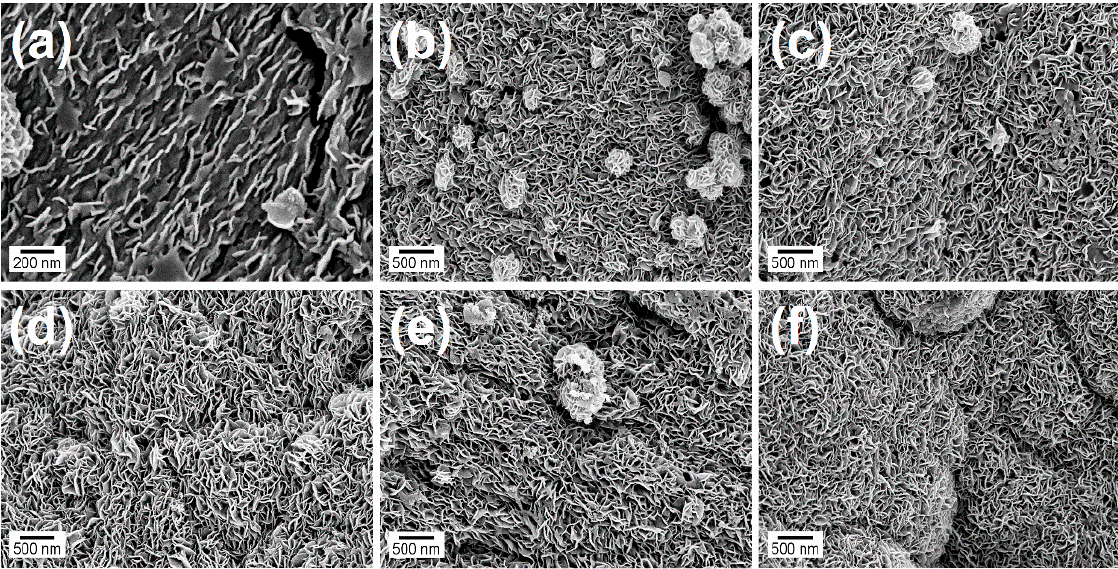
Figure 2. Scanning electron microscopy (SEM) images of the MoS 2 nanostructures grown directly on cellulose paper substrates with a synthesis temperature of 220 ◦ C and time of: ( a ) 05 min, ( b ) 15 min, ( c ) 30 min, ( d ) 45 min, ( e ) 60 min, and ( f ) 120